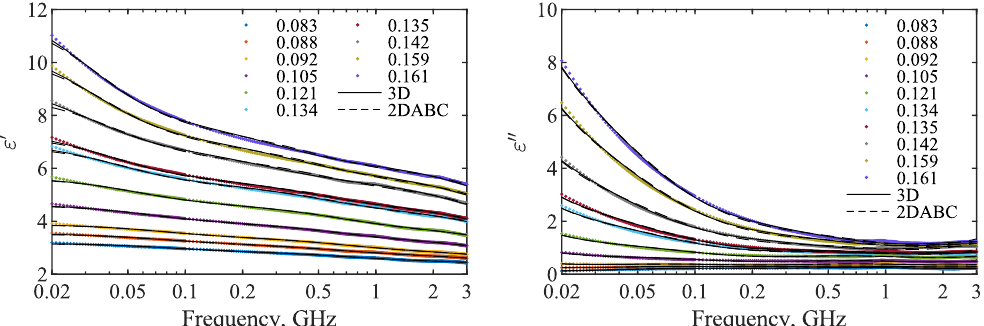
Figure 4. Models 3D (solid black lines) and 2D-ABC (dashed black lines) fitted to the spectra (dots of various colors) of ε (cid:48) ( left graph) and ε (cid:48)(cid:48) ( right graph) of rapeseed samples of moisture content given in the legend (in g g − 1 ). For clarity, for each moisture content, only one spectrum is